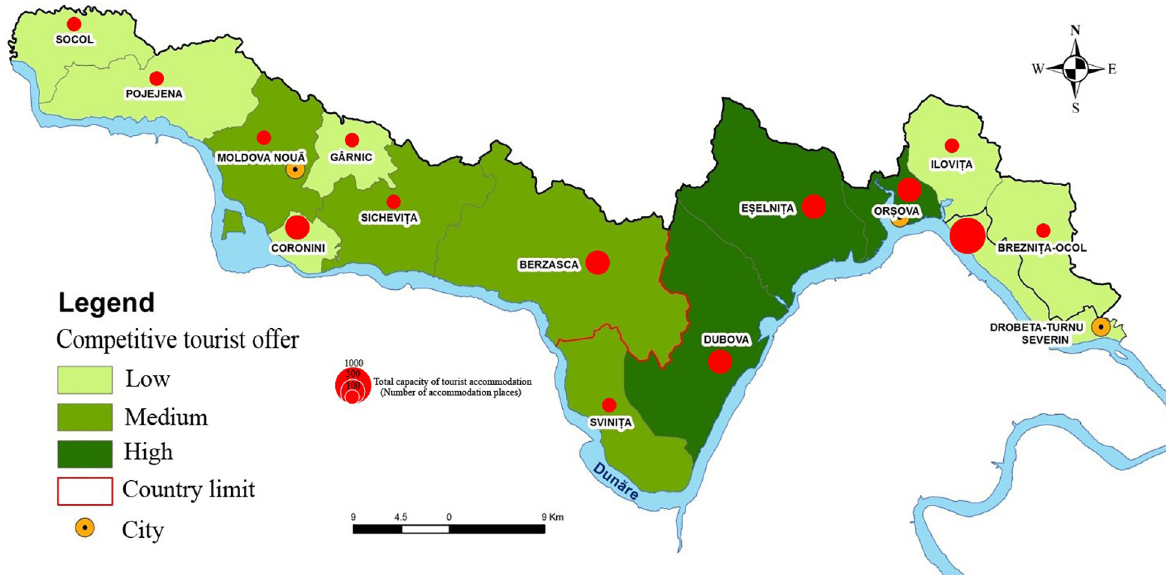
Fig. 9. The competitiveness of tourism.